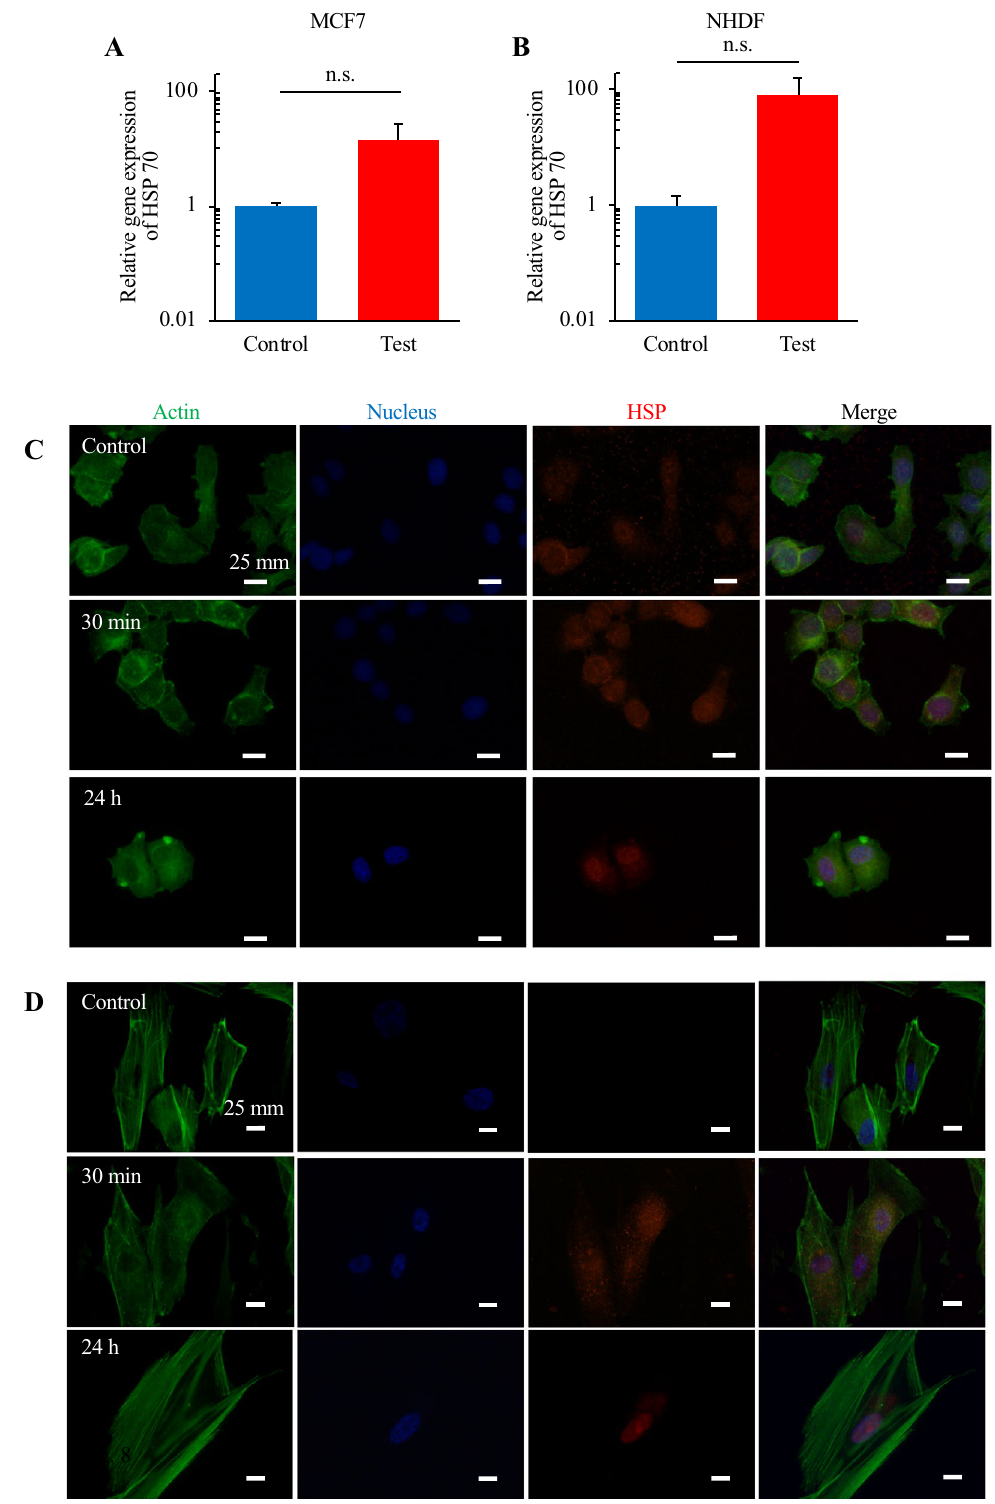
Figure 7. Comparison of the expression of HSP70 in MCF-7 cells ( A and C ) and NHDFs ( B and D ) after thermal stimulation. RT-qPCR assay ( A and B ) (n = 3, mean ± SD) and immunofluorescent staining ( C and D ) were performed. Actin, the nucleus, and HSP were stained green, blue, and red,